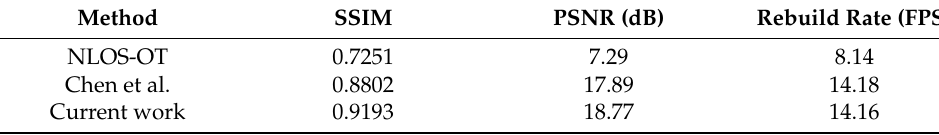
Table 1. Reconstruction quality comparison of methods on simulated